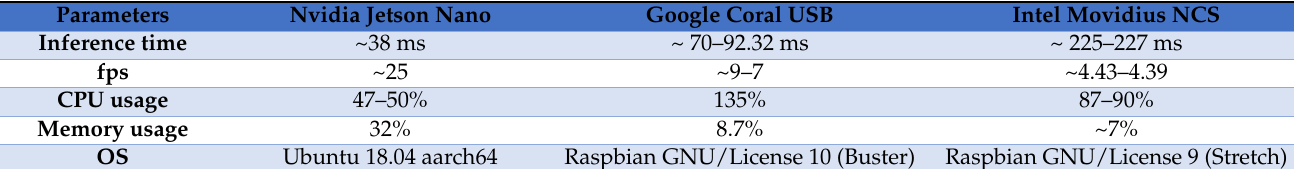
Table 6. Edge AI hardware comparison